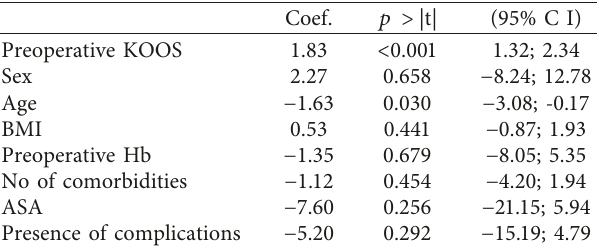
Table 5: Correlation between the preoperative data and postop- erative KOOS. The preoperative KOOS was positively associated with the postoperative KOOS, while age was negatively associated. Coef.